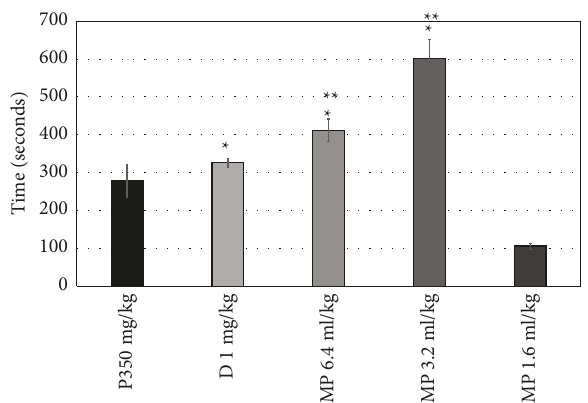
Figure 1: Effects of MPO (6.4, 3.2, and 1.6ml/kg) on the latency time of the first convulsion in the pilocarpine-induced epilepsy model in mice, ∗ P < 0 . 5 when contrasted to the P350 group, ∗∗ P < 0 . 5 when contrasted to the D group. P: pilocarpine, D: di- azepam, MPO: Mentha piperita L .